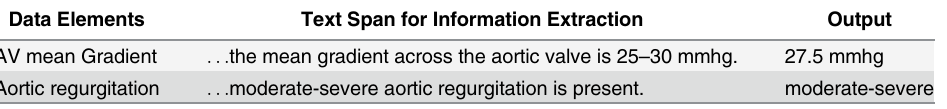
Table 2. Examples of EchoInfer ’ s identification of data element and corresponding value structured